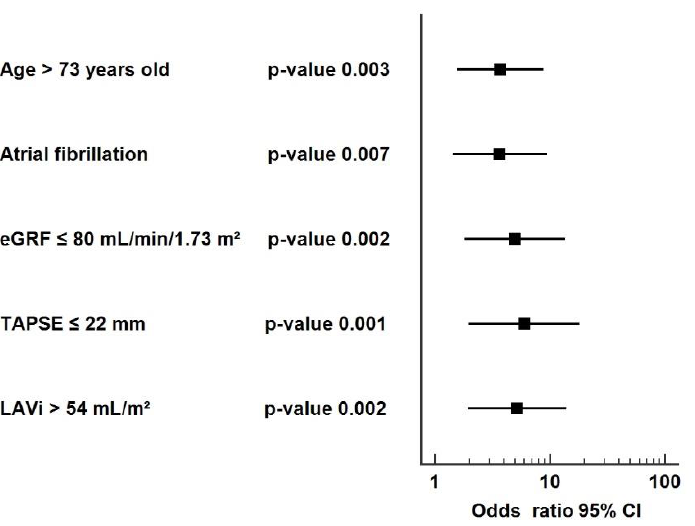
Figure 5. Forest plot for the predictors of NT-proBNP ≥ 2910 pg/mL. The point estimate represents the odds ratio for each predictor; whiskers indicate a 95% confidence interval (CI).